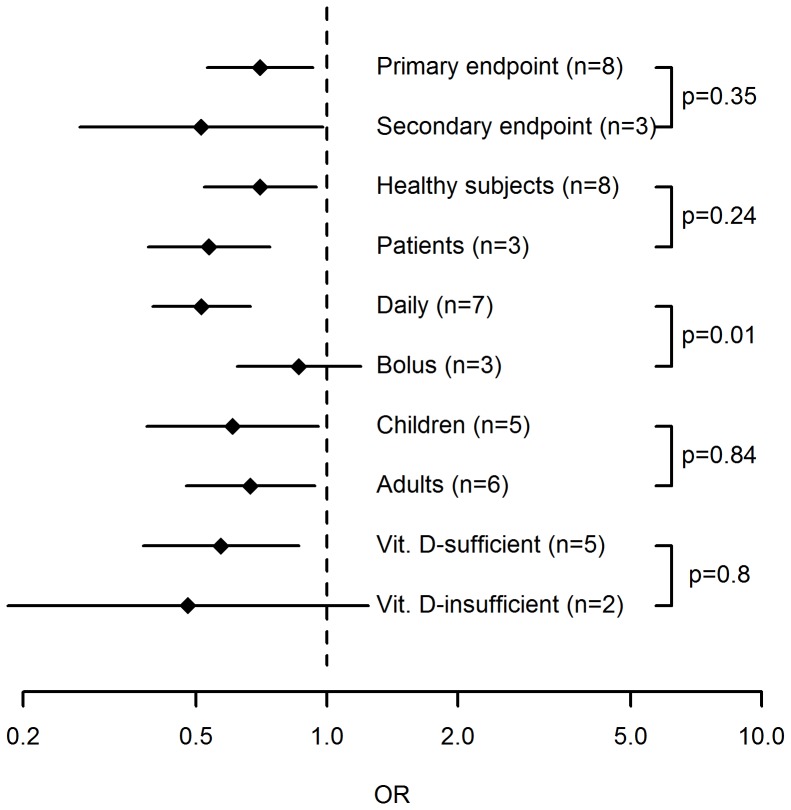
Subgroup analyses.Error bars indicate 95% confidence intervals of OR in subgropus of randomized trials. Subgroups were based on RTI being a primary or secondary endpont, trial participants being patients or healthy individuals, children or adults, and vitamin D-sufficient or insufficient, and vitamin D being adminstered daily or as bolus doses. Numbers indicate number of trials in each subgroup and p-values refer to between-group differences in random effects meta-regressions performed separately for each pair of subgroups.